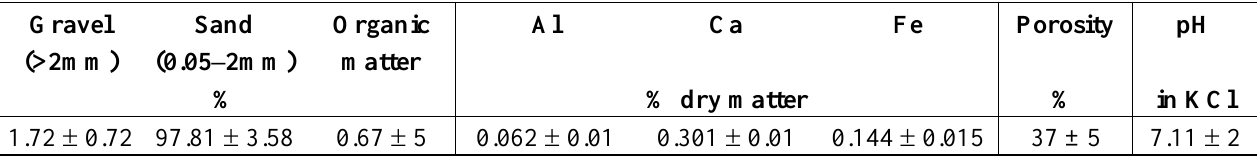
Table 2. Selected physicochemical characteristics of the substrate (medium sand) used in the constructed wetland (n = 3, mean values and